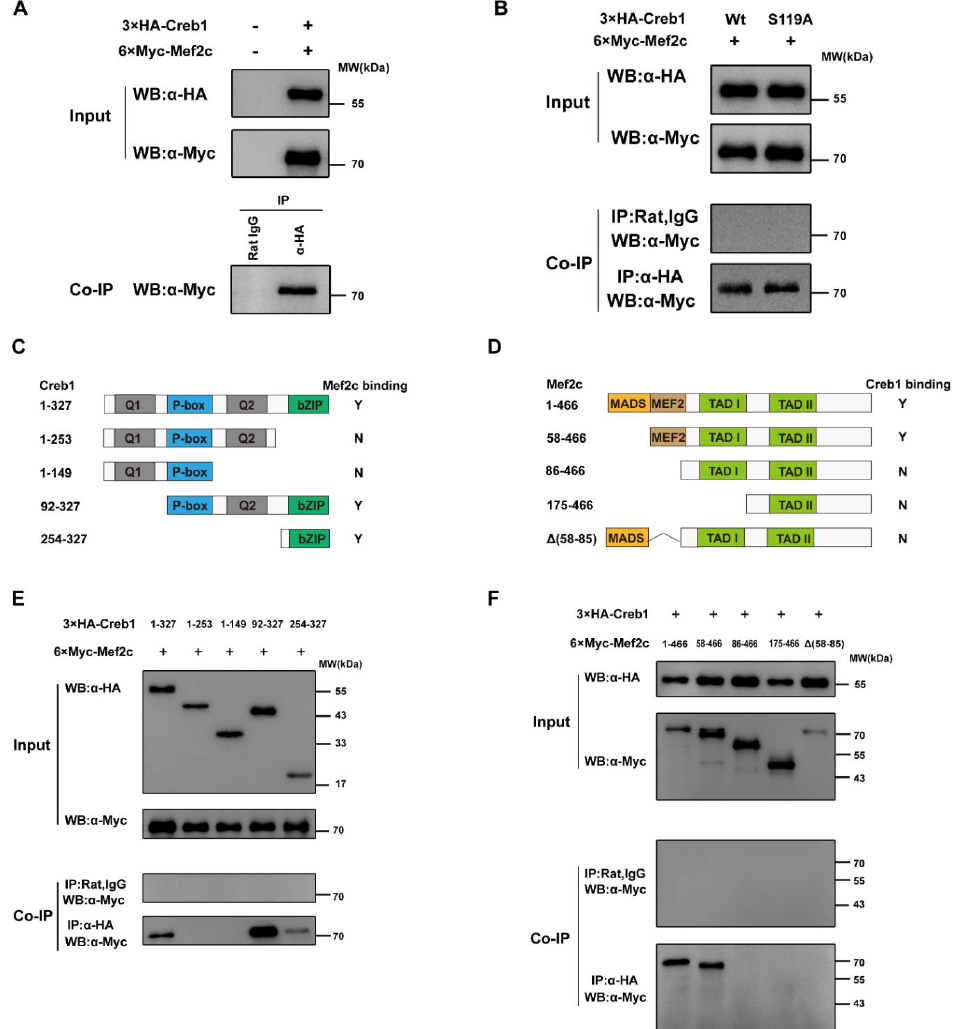
Figure 5. Protein–protein interaction between Mef2c and Creb1. ( A ) HEK293T cells were cotransfected 3×HA-Creb1 and 6×Myc-Mef2c for 24 h. The expression levels of Creb1 and Mef2c are detected by Western blot (WB) analysis with anti-HA or anti-Myc antibody, respectively. 6×Myc-Mef2c is coimmunoprecipitated with 3×HA-Creb1 with anti-HA antibody, but not detected in control rat IgG. ( B ) The interaction between Creb1 and Mef2c is not dependent on Creb1 S119 phosphorylation. 6×Myc-Mef2c and 3×HA-Creb1 or 3×HA-Creb1-S119A were cotransfected into HEK293T cells as the indicated combination for 24 h, followed by immunoprecipitated analysis. 6×Myc-Mef2c is coimmunoprecipitated by 3×HA-Creb1 or 3×HA-Creb1-S119A. Wt, wild-type Creb1. S119A, Creb1 Ser119 was mutated to Ala. ( C ) Schematic illustration of the interaction between Creb1 deletional constructs and Mef2c. Y, yes; N, no; Q1, glutamine-rich domain 1; P-box, phosphorylation domain; Q2, glutamine-rich domain 2; bZIP, basic region/Leu zipper domain. ( D ) Schematic summary of the interaction between Mef2c deletional constructs and Creb1. Y, yes; N, no; MADS, MADS-box domain; MEF2, MEF2 domain; TAD I, transactivation domain I; TAD II, transactivation domain II. ( E ) Analysis of the protein interaction between Cre1 deletion and Mef2c by coimmunoprecipitation (Co-IP) assays. Mef2c can only be immunoprecipitated by the deletions harboring the bZIP(254−327) domain of Creb1. ( F ) Coimmunoprecipitation (Co-IP) assays reveal that constructs containing the MEF2(58−85) domain interact with Creb1.